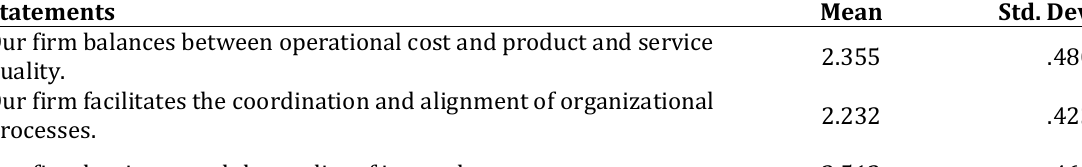
Table 1: Competitive advantage descriptive